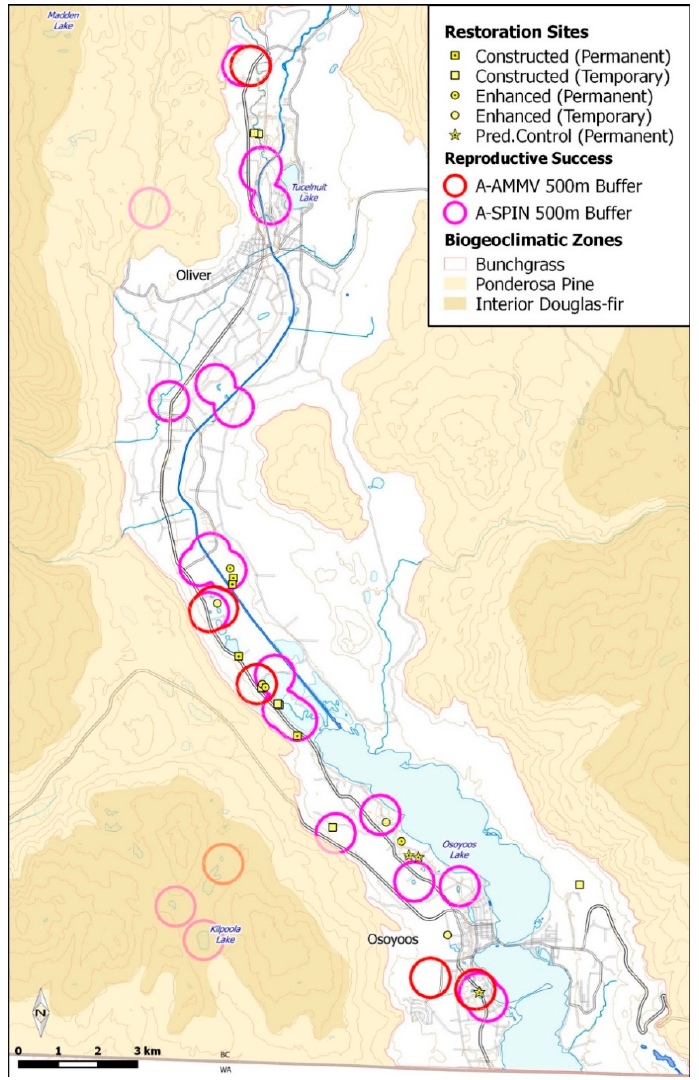
Figure 2. Location of pond habitat activities (construction N = 10, squares, enhancement N = 8, circles, non-native species removal N = 3, stars) in proximity to priority known Basin spadefoot and Blotched tiger salamander breeding sites south Okanagan River Valley, British Columbia study area. Amphibian (A) species codes: A-AMMV Blotched tiger salamander, A-SPIN Great Basin